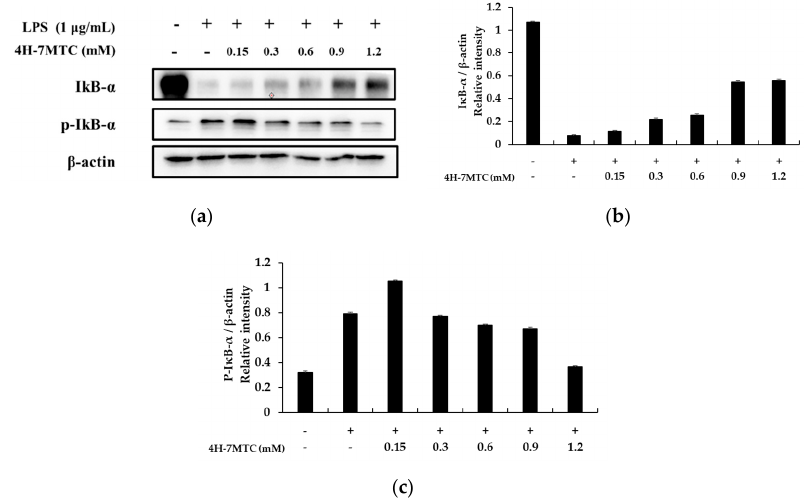
Figure 6. Effect of 4-hydroxy-7-methoxycoumarin (4H-7MTC) on the level of phospho-I κ B- α and I κ B- α in LPS-induced RAW264.7 cells. Lysates were prepared from cells pretreated with 4H-7MTC (0.15, 0.3, 0.6, 0.9, and 1.2 mM) for 1 h and then treated with LPS (1 μ g/mL) for 20 min. Western blotting was performed to detect the expression of I κ B α and p-I κ B α . β -actin was used as a loading control ( a ). Quantification of immunoreactive protein bands is shown via bar graphs ( b , c ).